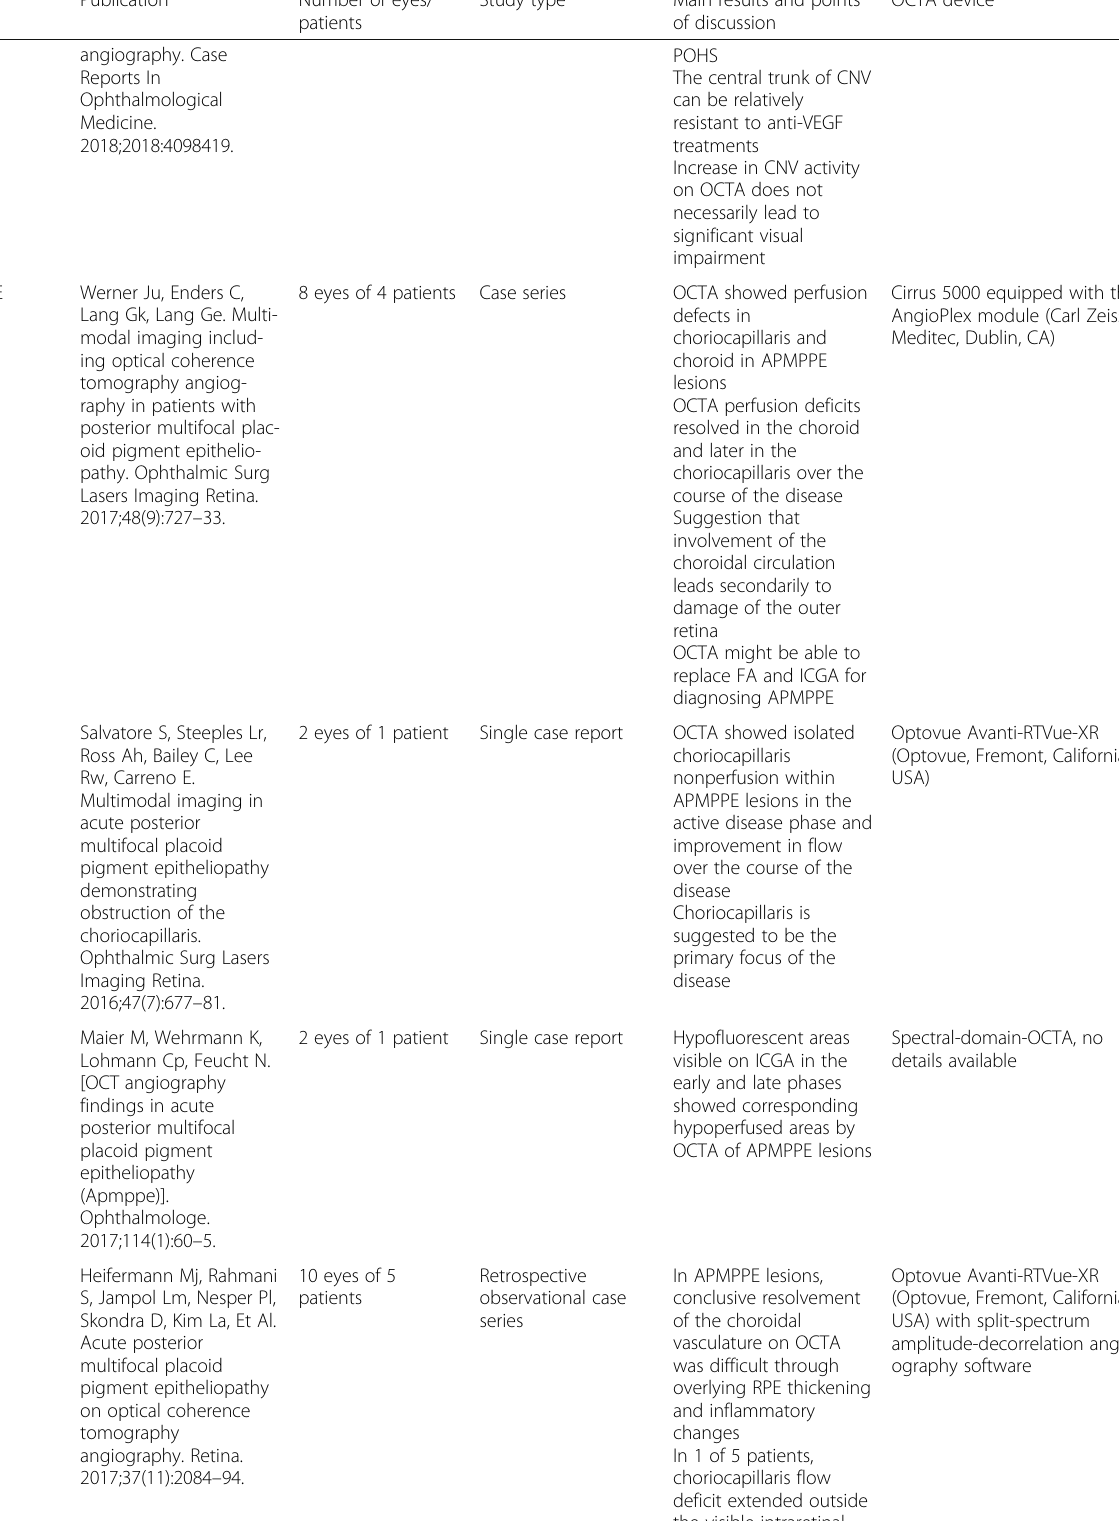
Table 1 Summary of publications on the implementation of OCTA in white dot syndromes (Continued)